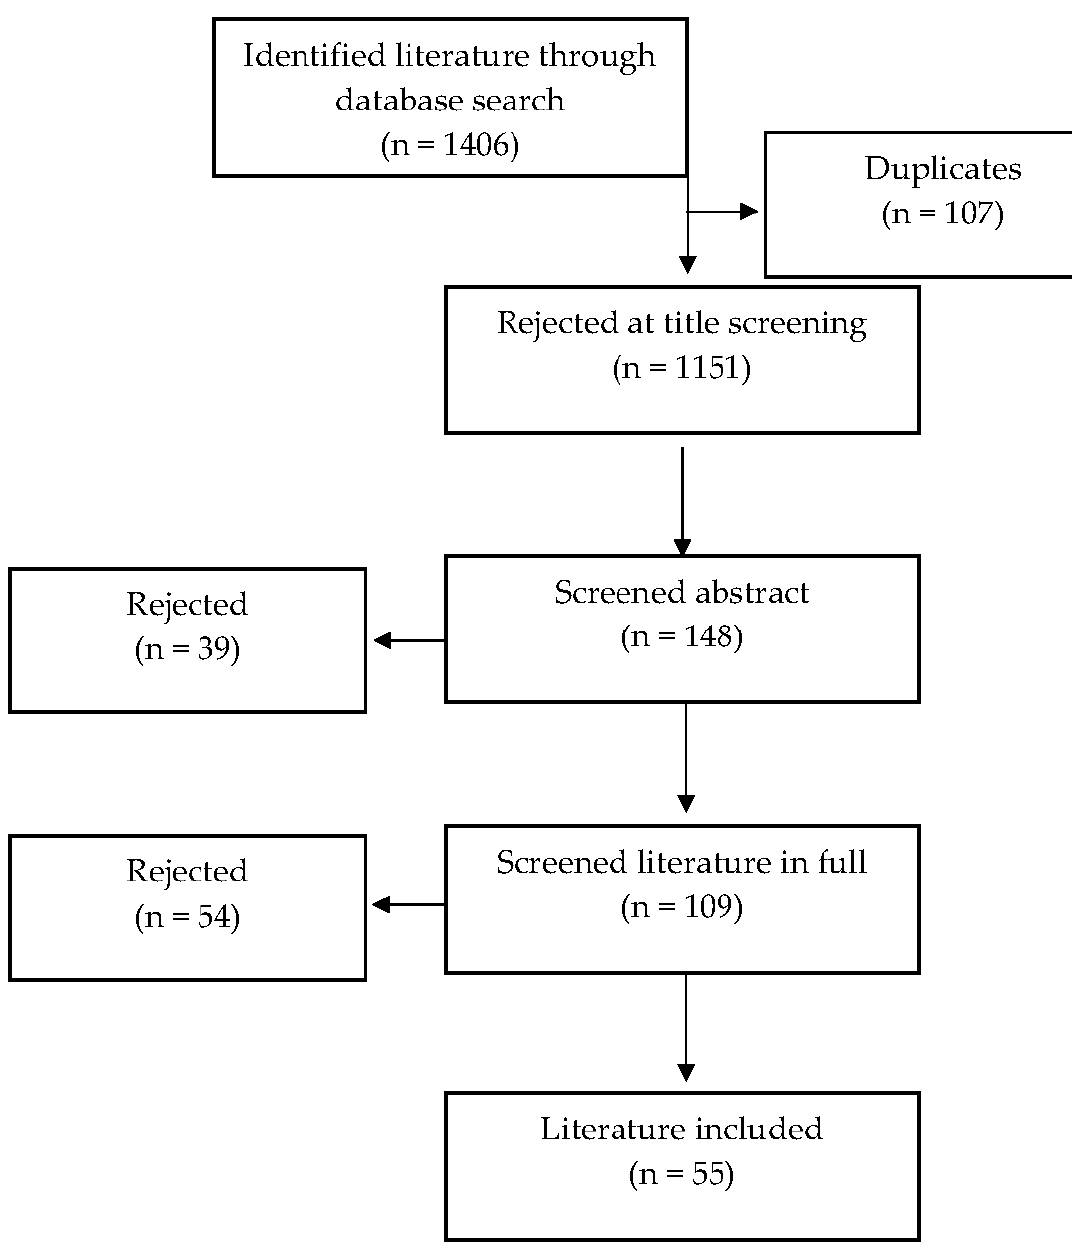
Figure 1. Flow diagram of identification, screening, and inclusion of studies.